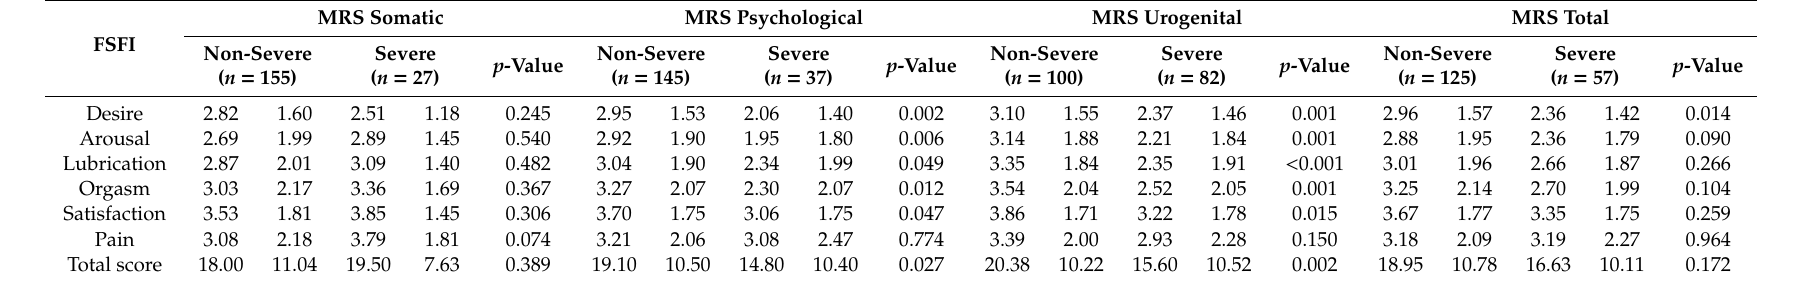
Table 2. Female sexual function according to the MRS domains and total score groups ( n =